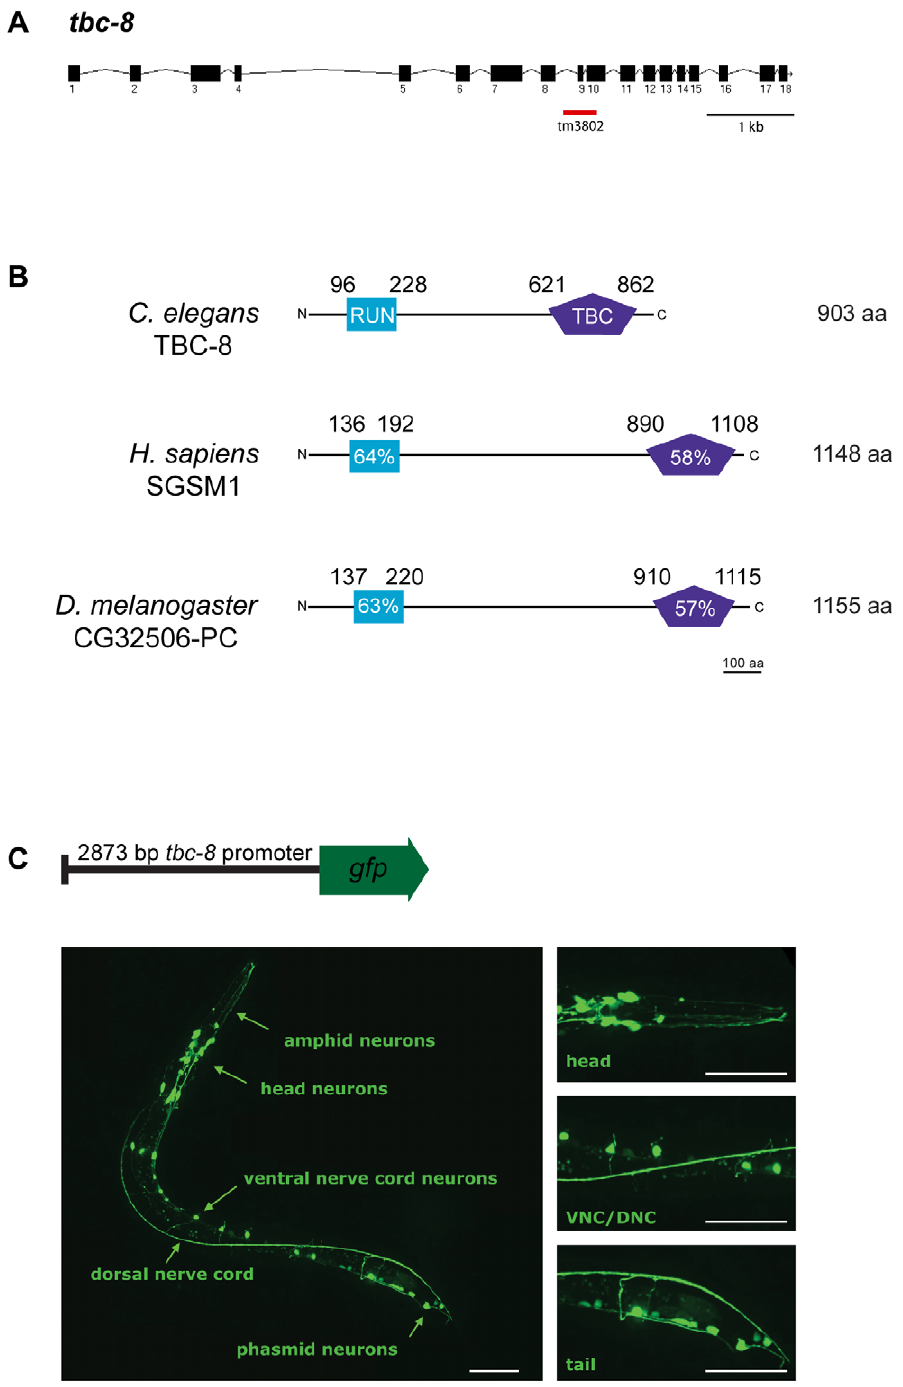
Figure 4. TBC-8 is exclusively expressed in neurons. (A) Gene structure of tbc-8 . Exons are depicted as black boxes and introns as black lines. The position of the tm3802 deletion is indicated (red line). (B) TBC-8 is evolutionarily conserved. Orthologs of TBC-8 are found in H. sapiens and D. melanogaster . TBC-8 contains two predicted domains, a RUN domain (blue) and a TBC-domain (purple). Percentage similarities for both domains are shown relative to C. elegans TBC-8. For full protein sequences of TBC-8 and its orthologs, see Figure S4. (C) Schematic representation of a construct containing a 2873 bp tbc-8 promoter fused to gfp . This transcriptional reporter construct was injected into wild type worms and gfp expression was imaged in stage three larval (L3) worms by confocal microscopy. tbc-8 expression was observed in the neurons of the head including amphid neurons, the ventral nerve cord (VNC) neurons and in neurons of the tail (phasmid neurons). The right panel shows magnifications of the respective regions. Scale bars represent 50 m m.